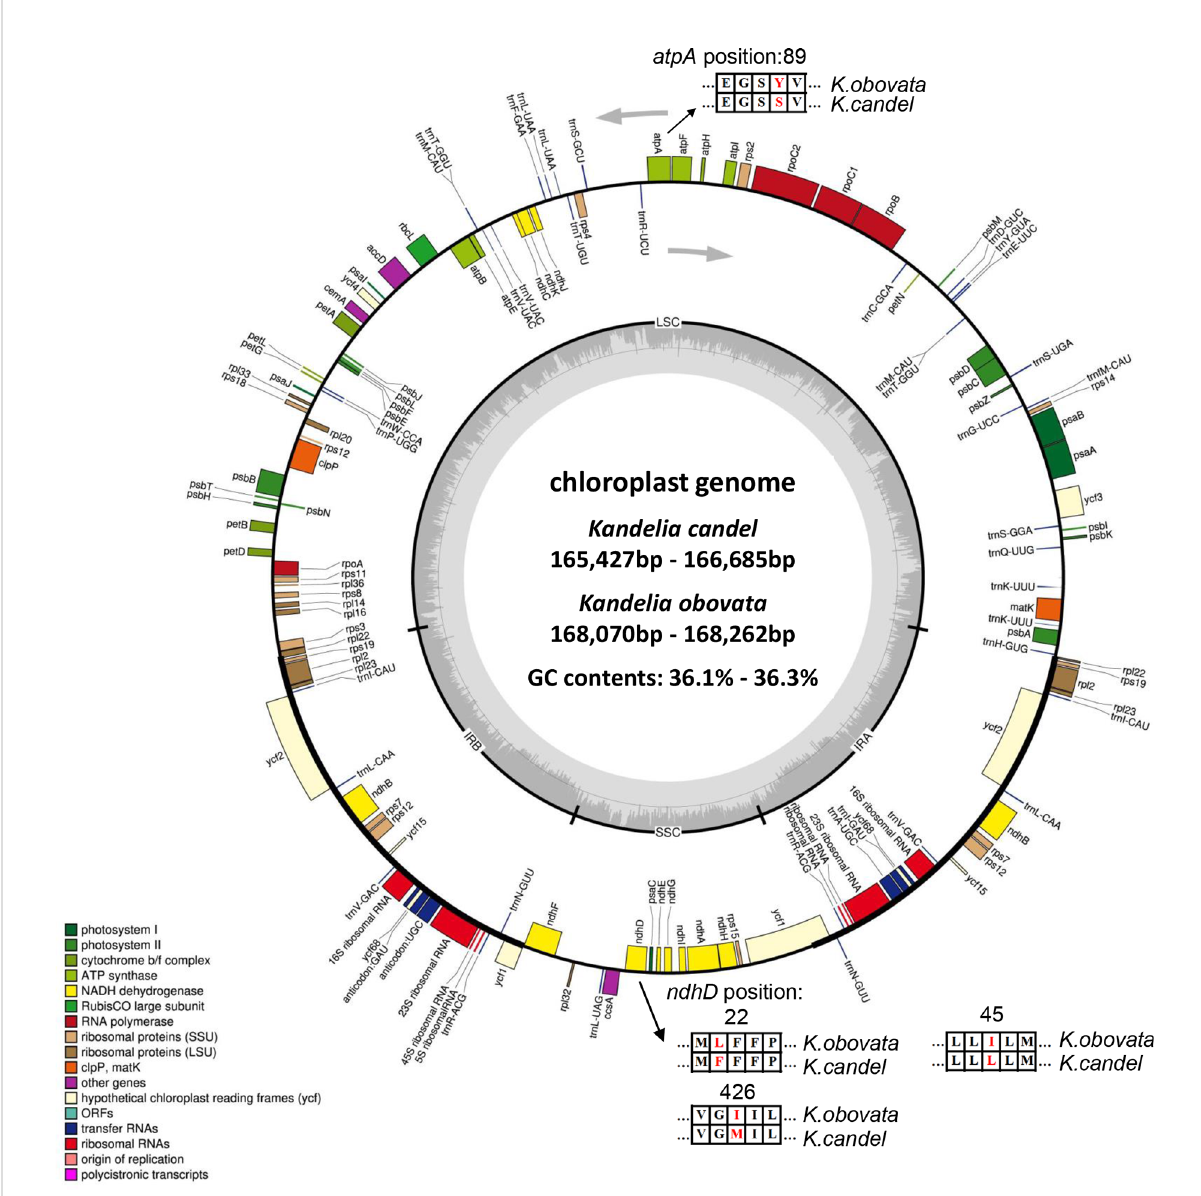
FIGURE 3 Gene maps of the chloroplast genomes of Kandelia . Genes shown outside the outer circle are transcribed clockwise, and genes shown inside the circle are transcribed counterclockwise. Genes belonging to different functional groups are color coded. The dashed area in the inner circle indicates the GC content of the chloroplast, and the light gray area corresponds to AT content of the chloroplast. Point mutations of atpA and ndpD gene were shown between K. obovata and K. candel